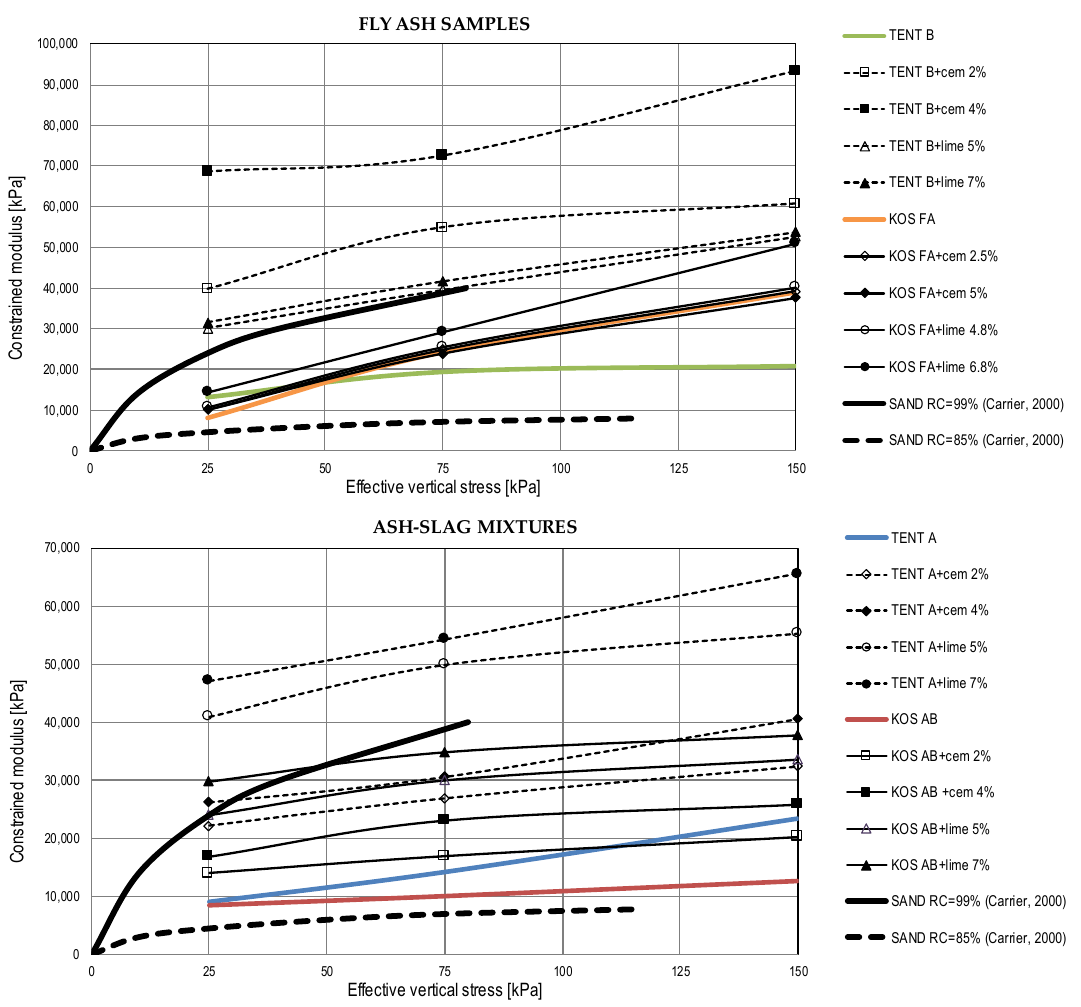
Figure 11. Constrained moduli of waste materials and sands.